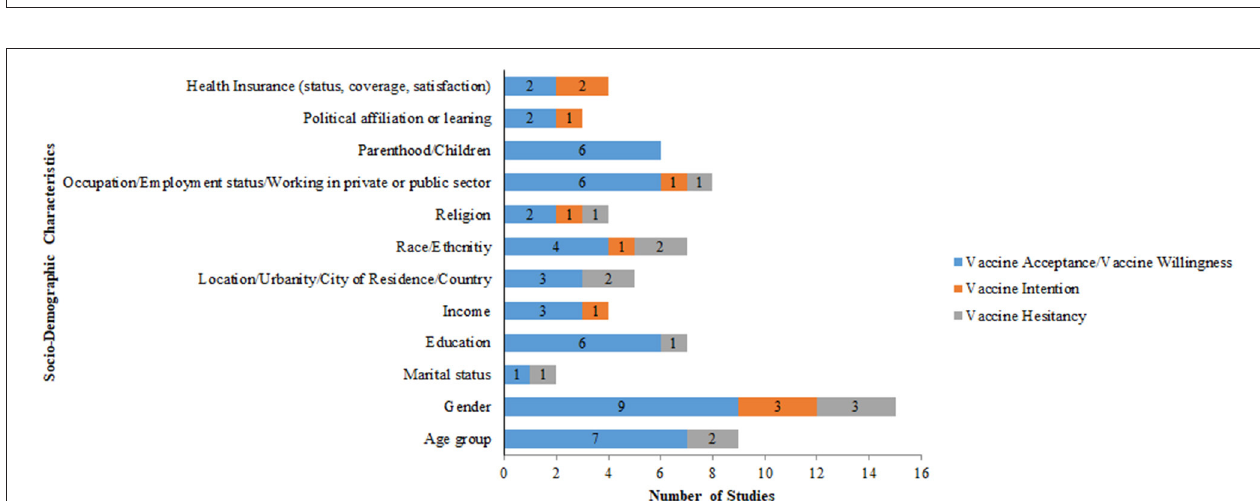
FIGURE 8 | Socio-demographic factors affecting COVID-19 vaccine acceptance, vaccine intention, and vaccine hesitancy.